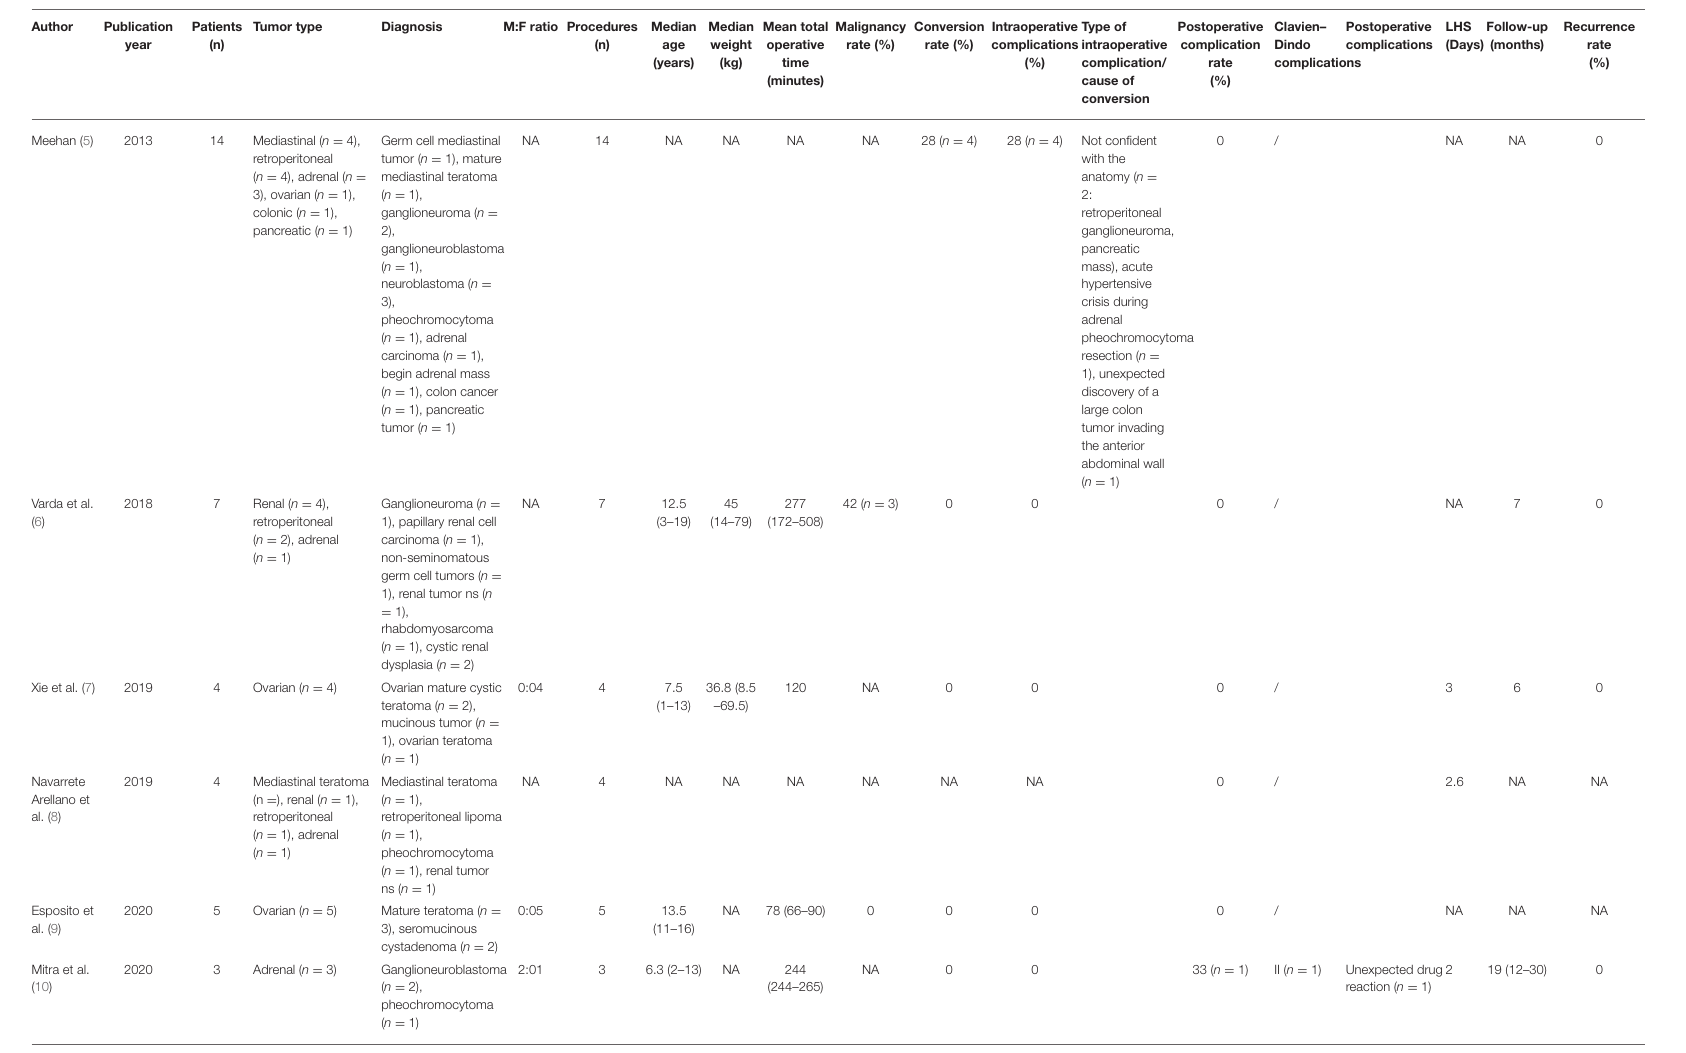
TABLE 2 | Results of the systematic